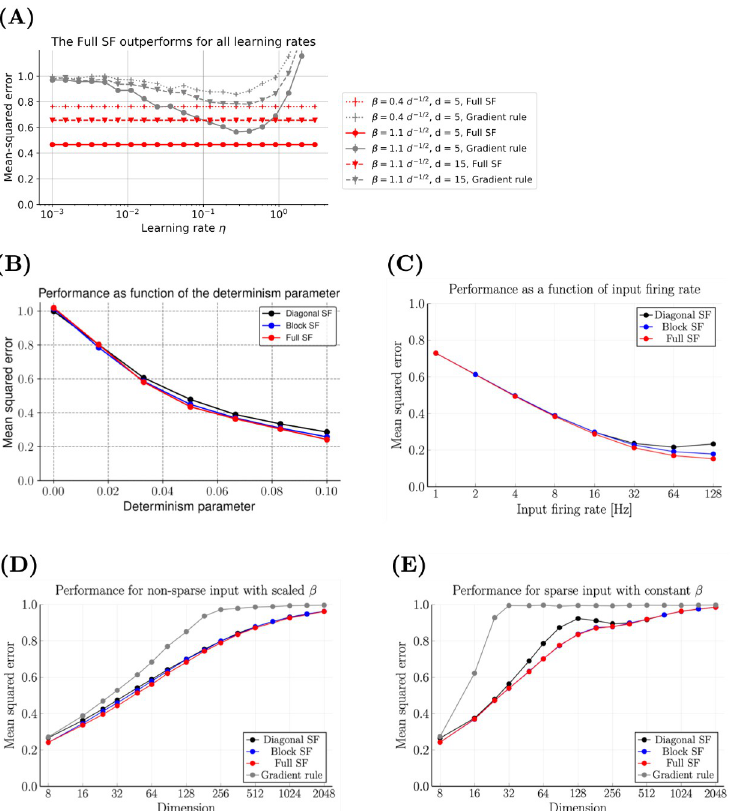
Fig 2. The Full Synaptic Filter has the best overall MSE across a range of parameters. (A) The MSE of the Full Synaptic Filter (red) is lower than the MSE of a gradient learning rule (grey) for a range of learning rates η . The symbols indicate three combinations of determinism β and dimension d . Consistent with (B, D) , the lowest MSE (black) is obtained at the lowest dimension and highest determinism. (B) The MSE of Full Synaptic Filter (red line) and the Diagonal Synaptic Filter (black line) decrease as the determinism β increases. At β = 0, the MSE corresponds to the equilibrium variance of the prior, s 2 ¼ 1 . The Diagonal Synaptic Filter performs slightly worse. (C) Increasing the ou input firing rate ρ decreases the MSE and increases the difference between the variants of the SF. The reason for the lower MSE is that the output neuron fires more frequently, thus more information is available for learning at the synapses. The MSE differences between the SF variants are caused by an increase in correlations between the inputs, and hence correlations in the weights. The full SF is best able to captures correlations while the diagonal SF does worst. The block SF falls in between these two. (D) The MSE of all learning rules increases monotonically with the number of dimensions until it saturates at s 2 ¼ 1 . The variants of the SF perform better than the optimal gradient rule, ou particularly in high dimensions. The MSE difference between the SF variants are qualitatively similar to (C) , particularly visible in the interval 16 � d � 128. For comparability, the expected output firing rate is kept constant by scaling the slope/determinism parameter β / d − 1/2 . (E) With sparse inputs, the performance of all learning rules drops. The optimised gradient rule fails to learn for d > 32. The performance of the block and the full SF is identical because the sparsity of the inputs induces correlations only in the blocks of the covariance matrix that both learning rules share. The diagonal SF performs worst because it cannot capture the correlations. For d > 256, the performance of SF variants is indistinguishable again. number of hidden weights is contained in the same number of observed output spikes. The Synaptic Filters outperform the gradient rule by a large margin. The performance differences between the Synaptic Filters are small but consistent for d < 128. They resemble the ordering found before: the Full Synaptic Filter outperforms the Block Synaptic Filter and the Diagonal Synaptic Filter is worst. The performance of all learning rules improves when increasing the amount of available information about the hidden weights, e.g., by increasing g the firing rate 0 of the output neuron directly or indirectly via a higher input firing rate ρ .